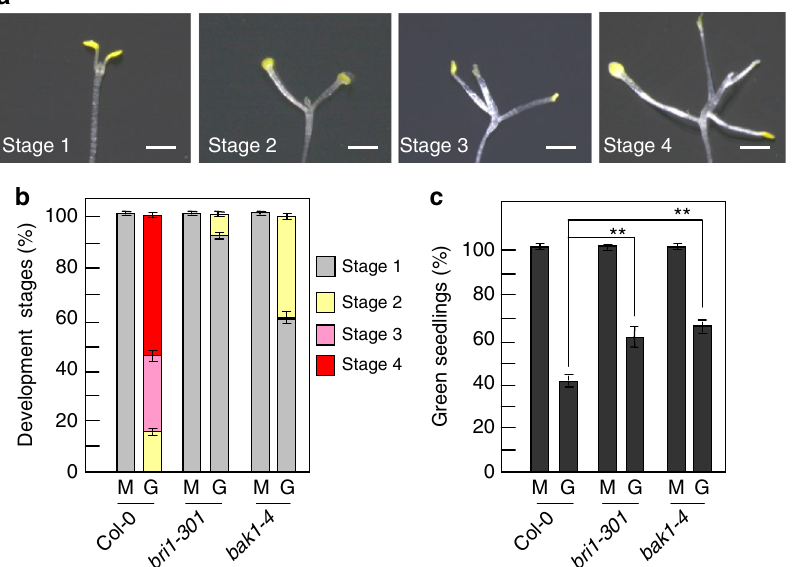
Fig. 1 BRI1 and BAK1 play key roles in sugar responses. a Different stages of dark-grown wild-type seedlings used for scoring sugar responses. b Comparison of developmental stages between Col-0, bri1-301 , and bak1-4 . Seedlings were grown vertically on medium supplemented with 1% glucose (G) or 1% mannitol (M) in the dark for 19 days ( n ≥ 83). c The percentage of Col-0, bri1-301 , and bak1-4 seedlings with green cotyledons. Seedlings were grown on medium supplemented with 6% glucose (G) or 6% mannitol (M) under constant light condition for 10 days ( n ≥ 89). Values in b , c are given as mean ± SD. ** P < 0.01 compared with the wild type by Student ’ s t -test. Scale bars, 2 mm ( a